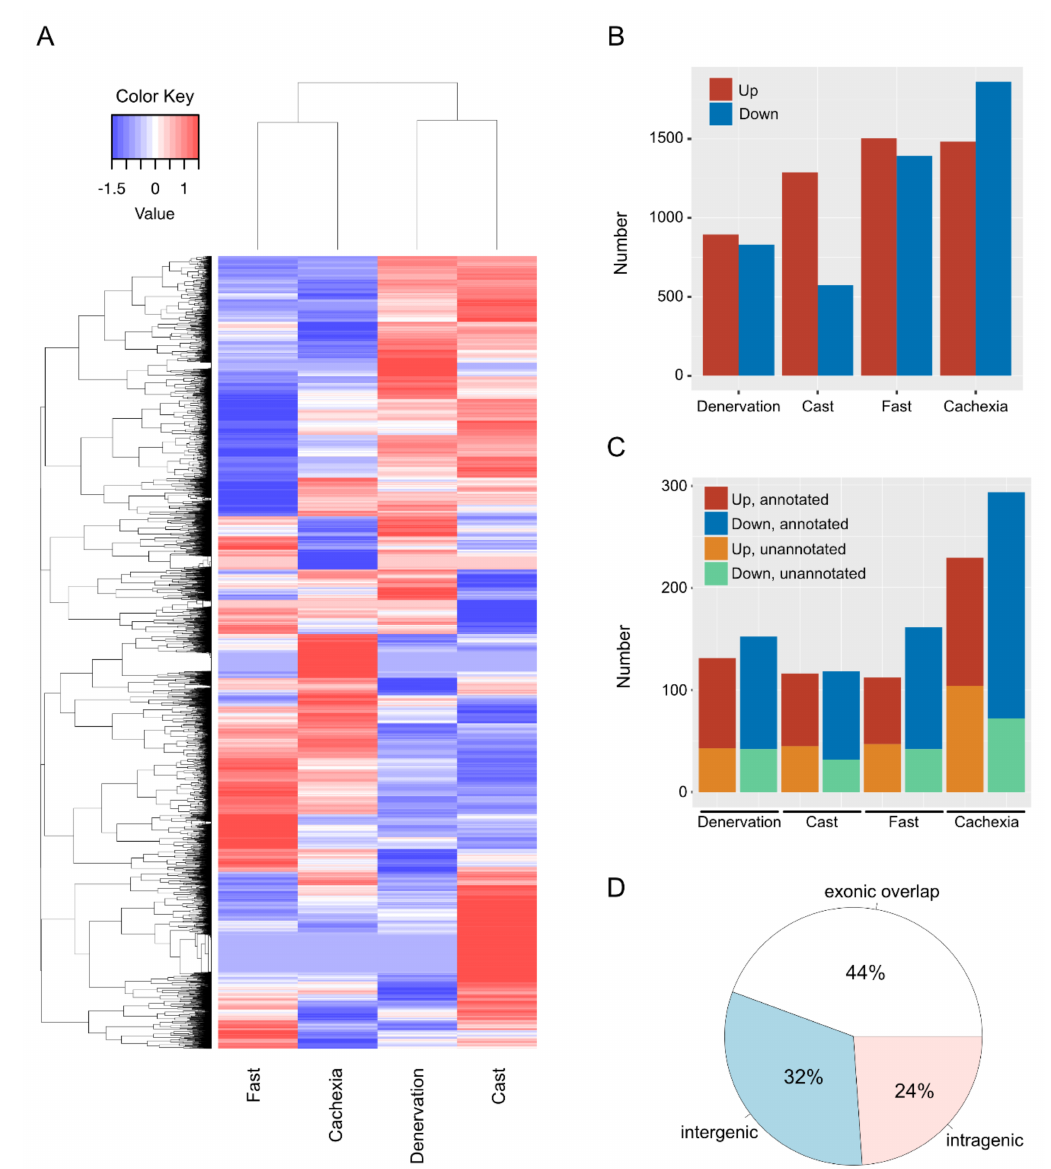
Figure 1. Changes in the expression levels of mRNAs and long non-coding RNAs (lncRNAs) in skeletal muscle atrophy conditions. ( A ) Hierarchical clustering analysis of differentially expressed genes, including both mRNAs and lncRNAs, after the induction of each atrophy model. ( B ) Numbers of up- and down-regulated mRNAs in each muscle atrophy condition. Red and blue indicate the up- or down-regulated mRNAs, respectively. ( C ) Numbers of up- or down-regulated lncRNAs after each treatment. Red, blue, orange, and green indicate up-regulated annotated lncRNAs, down-regulated annotated lncRNAs, up-regulated unannotated lncRNAs, and down-regulated unannotated lncRNAs, respectively. ( D ) Genomic positions of differentially expressed